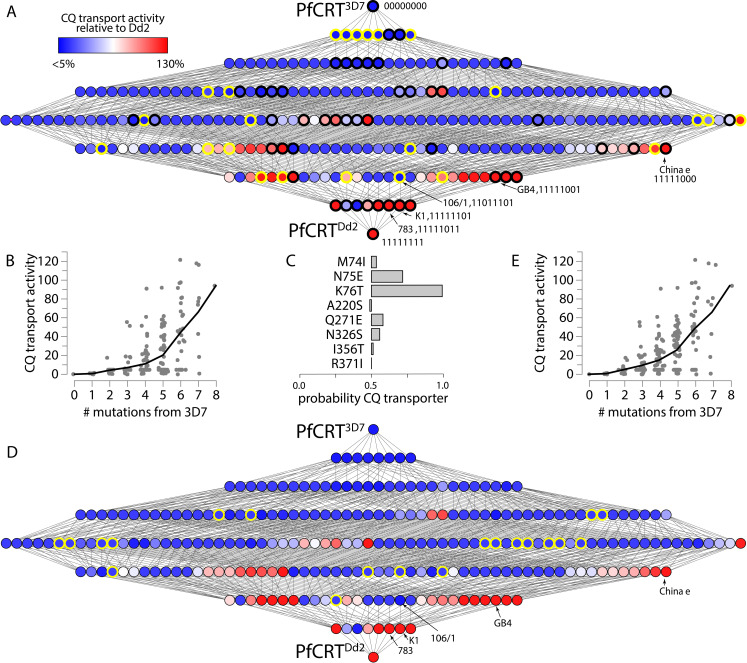
CQ transport activities increases across the genotype-phenotype map.A) The complete genotype-phenotype map with 76 measured phenotypes and 180 predicted phenotypes. As in Fig 1A, each node represents a genotype and each edge a mutation. The nodes outlined in black are the 52 genotypes that were measured by Summers et al., 2014 [24]; the genotypes measured in this study are outlined in yellow. B) Levels of CQ transport activity moving from PfCRT3D7 (no mutations) to PfCRTDd2 (eight mutations). Each data point represents a genotype; the line is the mean across genotypes that have the indicated number of mutations. C) The contribution of each mutation to the classifier, where the x-axis is the probability that the mutation is found in genotypes that transport CQ. D) The complete genotype-phenotype map estimated using the simple K76T classifier. The nodes outlined in yellow indicate phenotypes that are predicted to have <5% CQ transport activity with this classifier, but not in the initial classifier from panel A. E) Predicted CQ transport activity as a function of the number of mutations calculated using the simple K76T classifier.